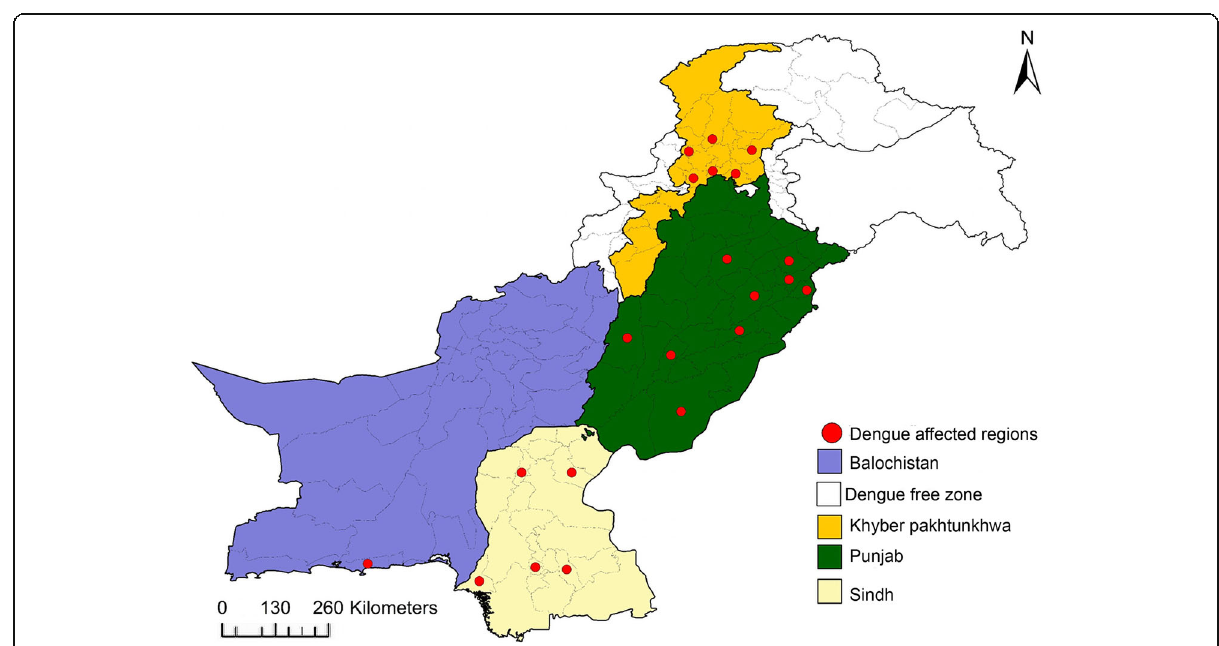
Fig. 2 Dengue epidemic in different regions of Pakistan from 1994-2018 (Ahmad et al. 2017). Map was created by ArcMap10.3 software (http://desktop.arcgis.com/en/arcmap/10.3/main/get-started/whats-new-in-arcgis.htm)